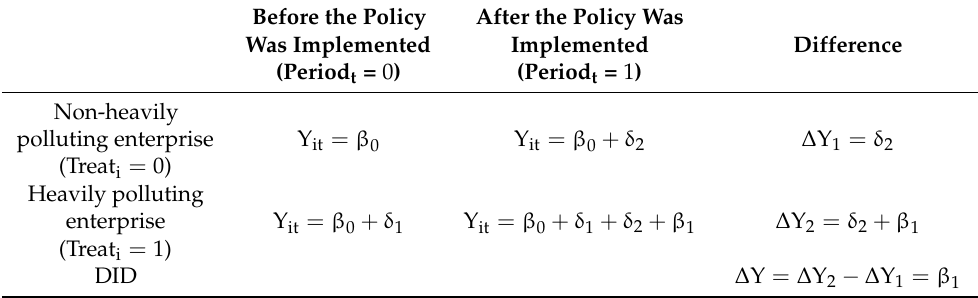
Table 2. DID model